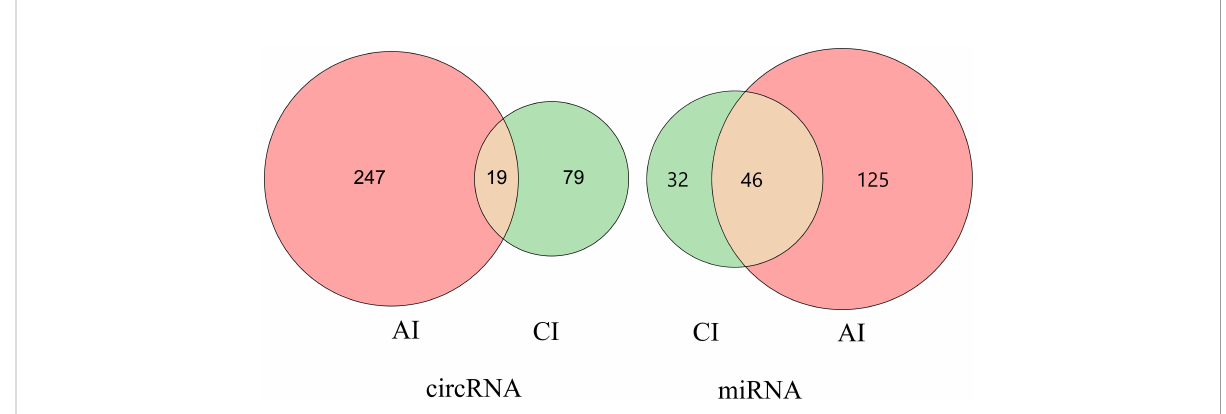
FIGURE 2 Venn diagram of the differentially expressed (DE) circRNAs and DEmiRNAs. the number of the common or unique DEcircRNAs and DEmiRNAs at two infection stages.